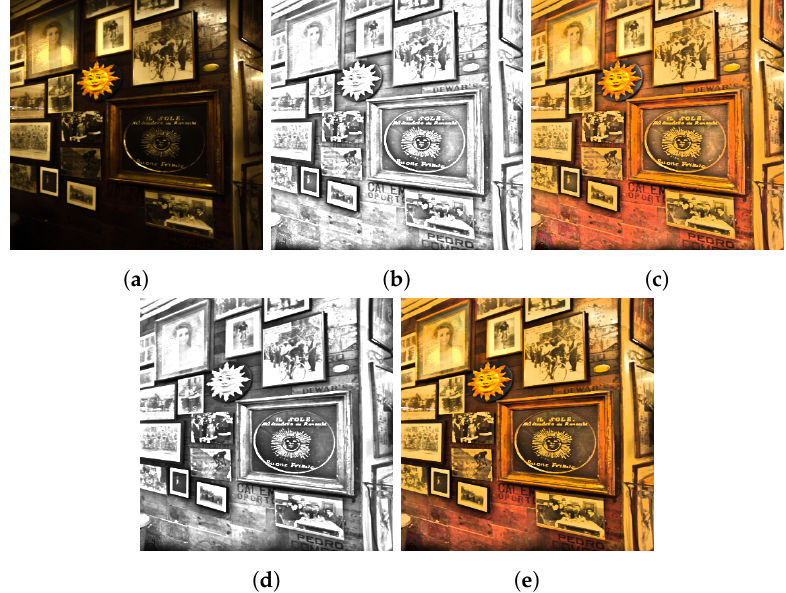
Figure 8. Comparison of SVD-CSC and CSC methods without SVD: ( a ) Original test image; ( b ) Reflectance using CSC general dictionary; ( c ) Image enhancement image using CSC general dictionary; ( d ) Reflectance using SVD-CSC general dictionary; ( e ) Image enhancement image using SVD-CSC general